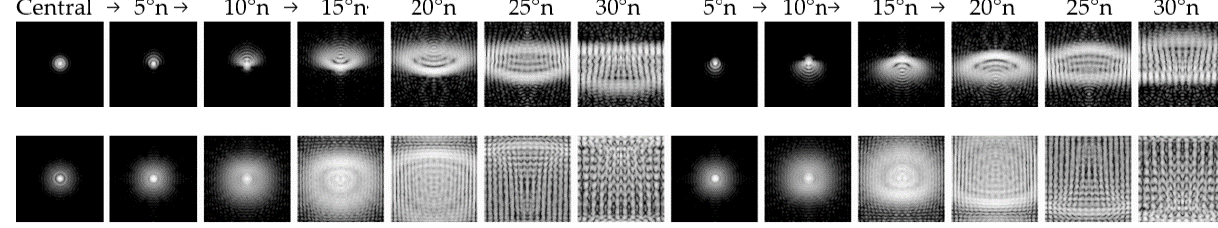
Figure 10. Simulated retinal image quality from central up to 30 ◦ nasal and temporal. ( Top row ): Proclear monofocal.